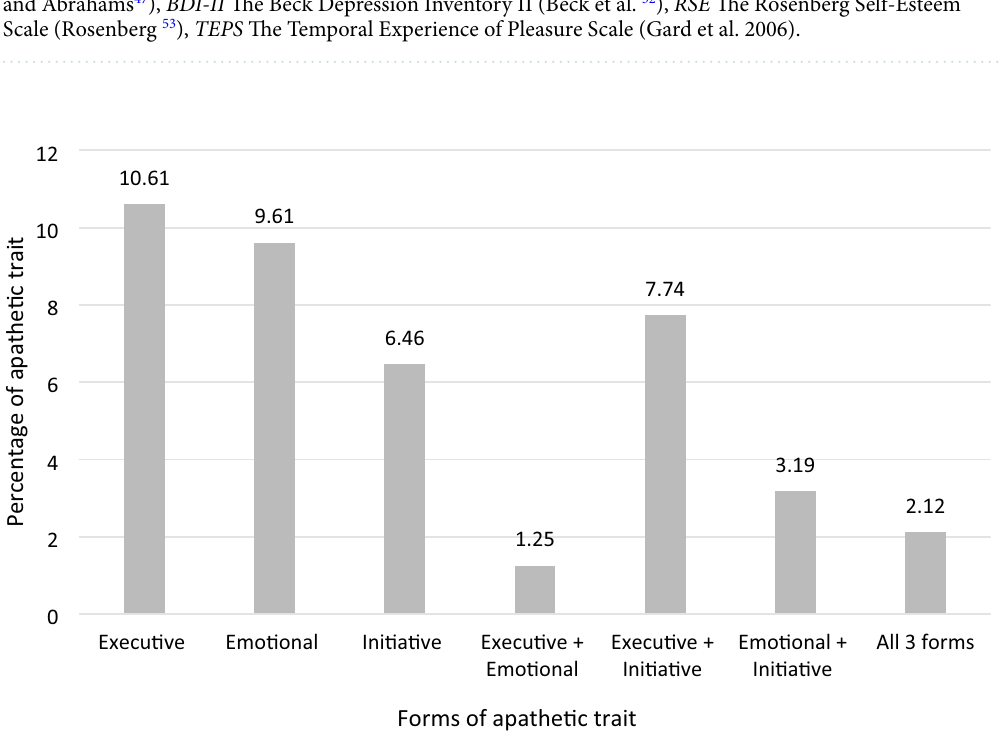
Figure 2. Combinations of multidimensional apathetic trait in the